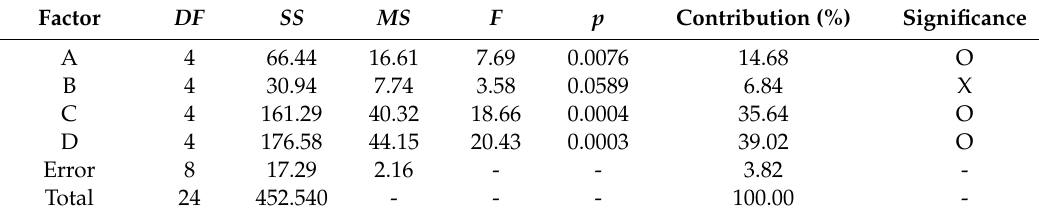
Table 6. Results of ANOVA for IF index.